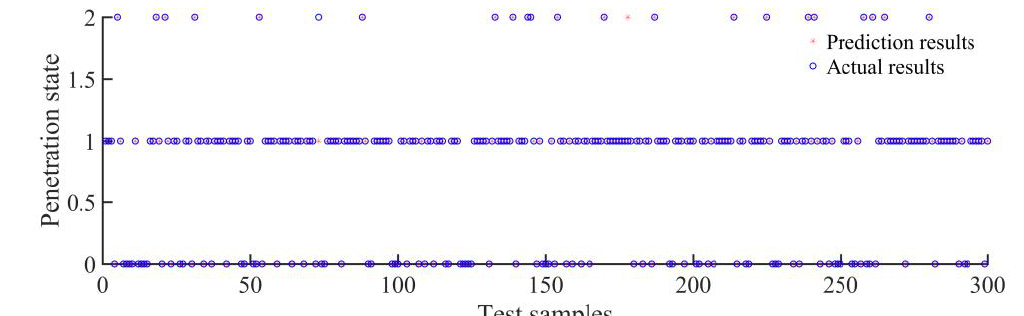
Figure 11. Recognition results of the penetration state. Table 3. Recognition accuracy of the penetration state.